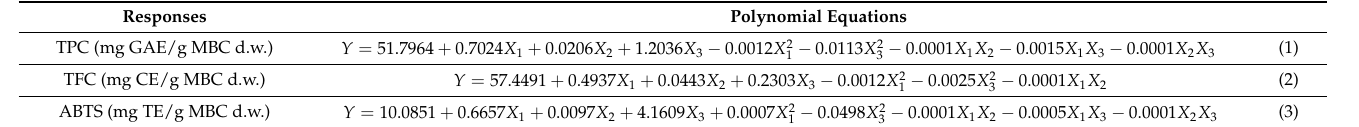
Table 3. Predicted second-order polynomial model equations of TPC, TFC and ABTS. Polynomial